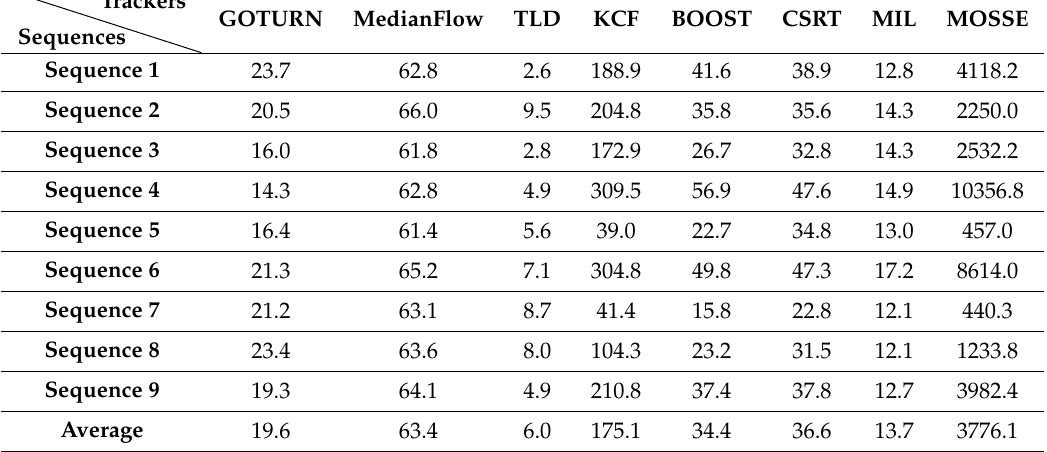
Table 2. Speed comparison of eight trackers on nine video sequences in terms of Frames Per Second (FPS).